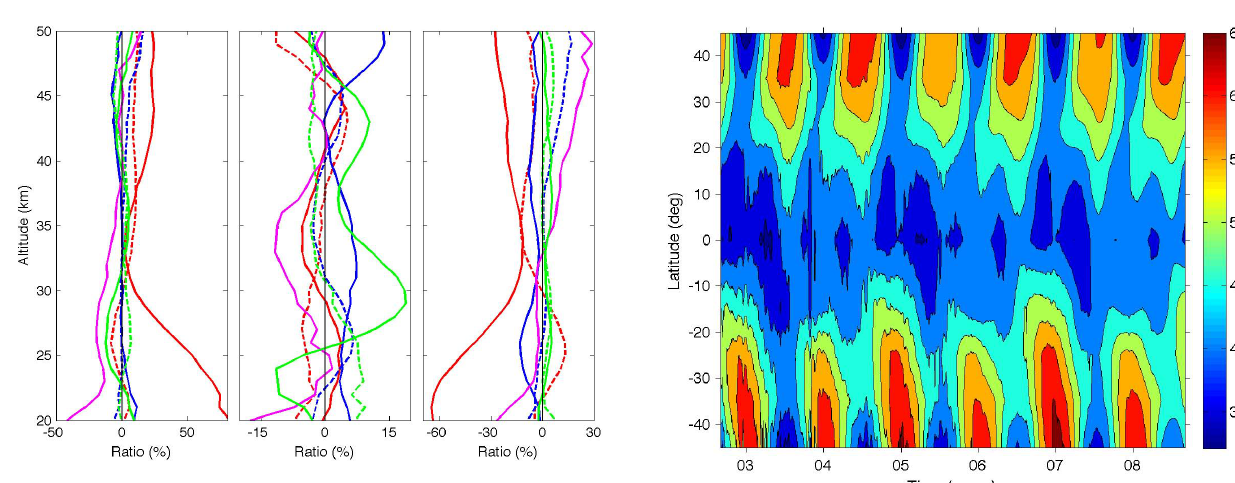
Fig. 22. The daily vertical partial NO 2 column in 20–50km as a function of time and latitude. The column is calculated from the time series and scaled by 10 15 moleculescm − 2 .